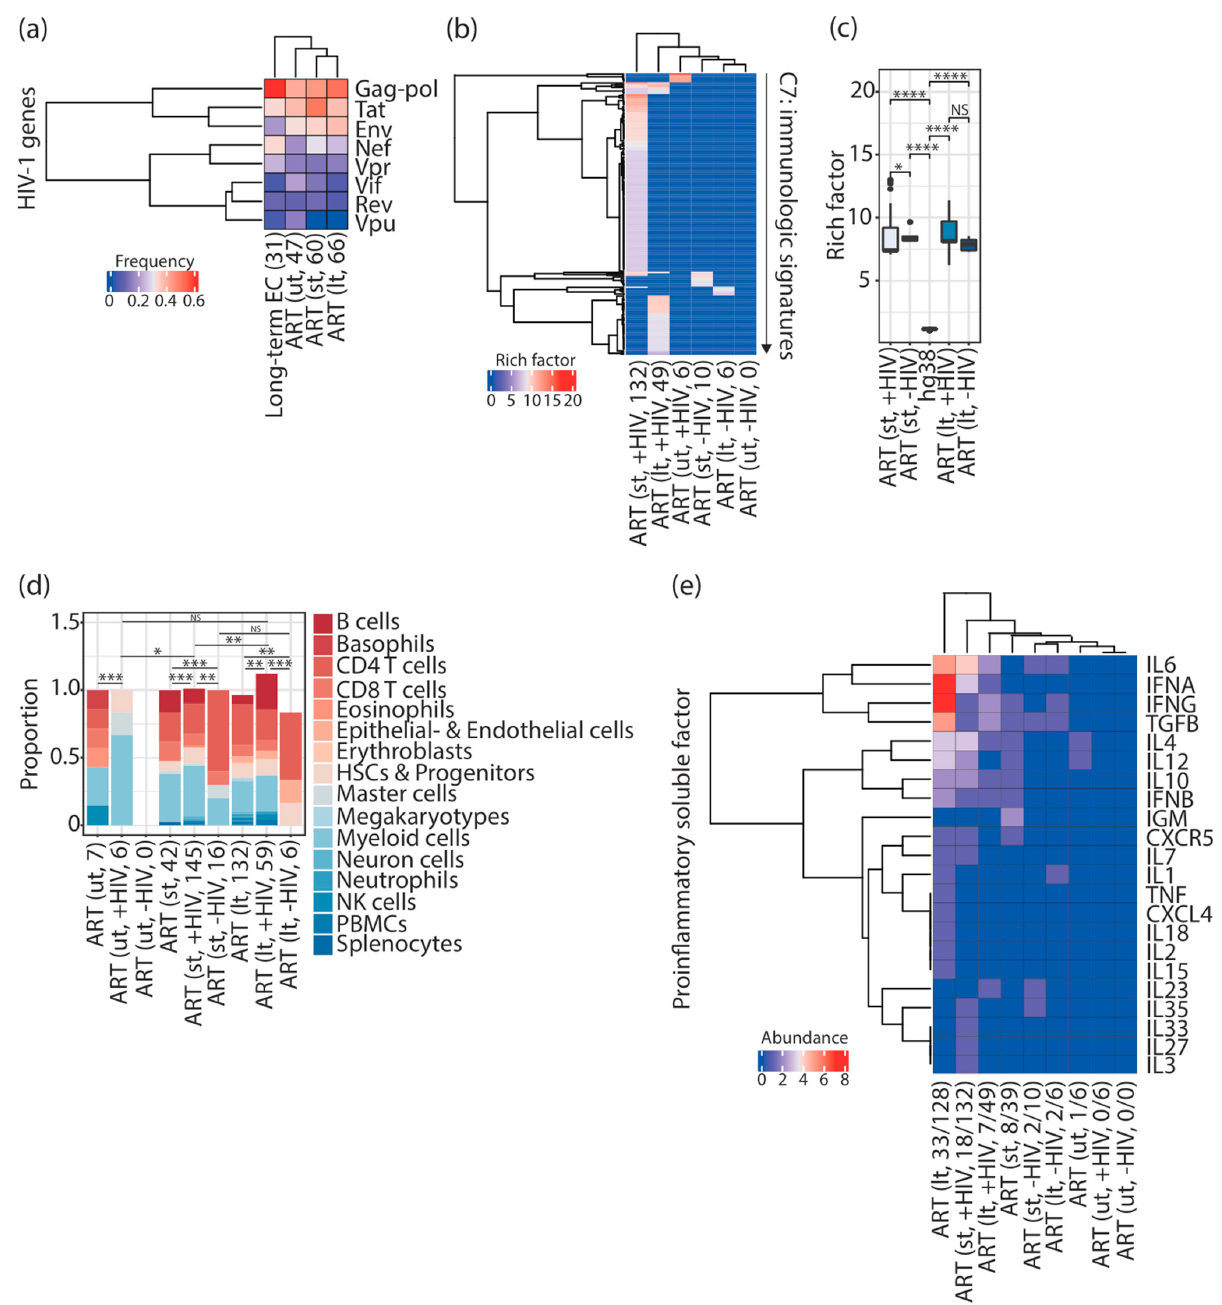
Figure 4. HIV-1-targeted gene sets that interact with HIV-1 contributed to enriching immunologic signatures alongside HIV-1 infections associated with ART. ( a ) Cluster heatmap representing the frequency of provirus-targeted genes interacting with HIV-1. Parentheses placed under the column indicate the total number of provirus-targeted genes reported to interact with HIV-1. ( b ) Cluster heatmap representing enriched immunologic signatures in HIV-1-infected individuals and elite controllers. Inside the parentheses, +HIV and − HIV indicate provirus-targeted genes reported to interact with HIV-1 or not, respectively. The number indicates the number of enriched immunologic signatures. The color scale represents the intensity of the enrichment represented by rich factors. ( c ) Box plots representing the enrichment of immunologic signatures represented by rich factors. Com- mands executed to calculate rich factors are described in the Materials and Methods. Statistical sig- nificance was calculated using the Wilcoxon test in R with default options. ( d ) Stacked bar chart representing the proportion of immune cell types present in enriched immunologic signatures in